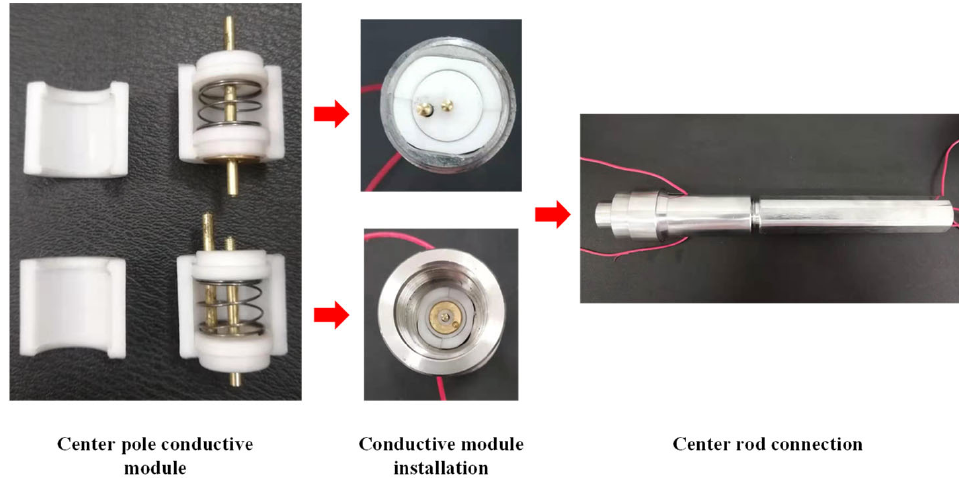
Figure 21. Physical prototype of the conductive center pole.